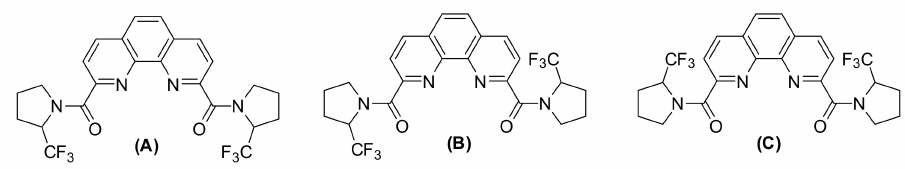
Figure 3. Structure of rotamers ( A – C